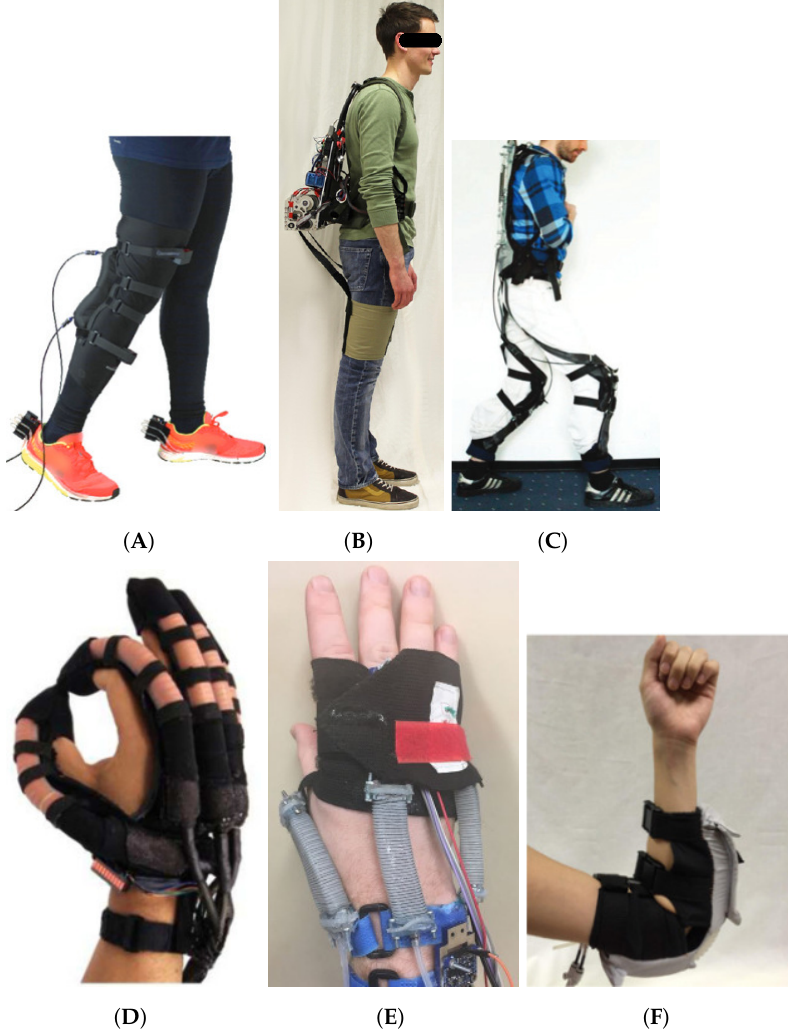
Figure 3. Wearable assistive robots with soft structure. Lower limb assistive robots: ( A ) soft- inflatable knee exosuit for rehabilitation [42] (Licensed under (CC BY 4.0)), ( B ) soft exosuit for hip assistance [44] (Reproduced with permission from Elsevier), ( C ) multi-articular hip and knee exosuit [46] (Reproduced with permission from Elsevier). Upper limb assistive robots: ( D ) soft robotic glove for assistance at home [47] (Reproduced with permission from Elsevier), ( E ) soft wearable wrist for rehabilitation [48] (Licensed under (CC BY 4.0)), ( F ) soft robotic elbow sleeve for assistance [49] (Licensed under (CC BY